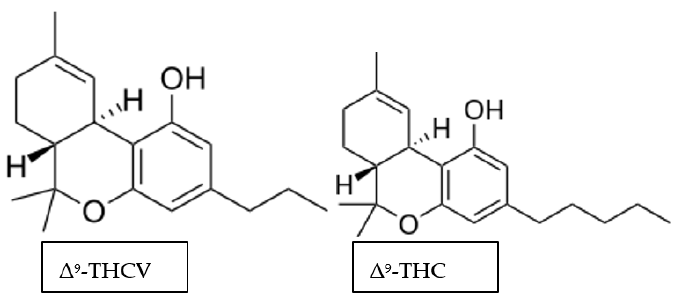
Figure 3. Chemical structure of the non-psychotropic delta-9-tetrahydrocannabidavarin ( ∆ 9 -THCV) and the psychotropic delta-9-tetrahydrocannabinol ( Δ 9 -THC).